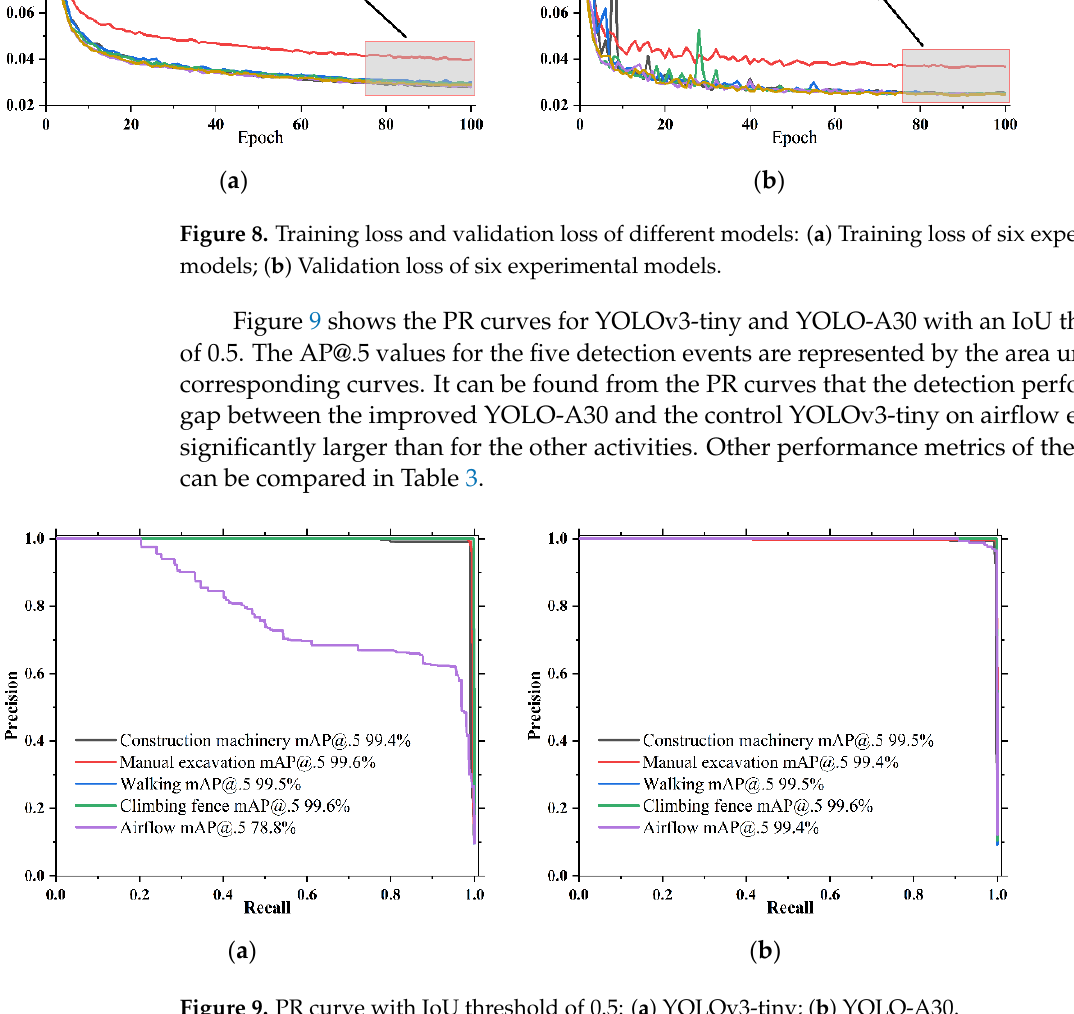
Figure 9. PR curve with IoU threshold of 0.5: ( a ) YOLOv3-tiny; ( b ) YOLO-A30. Table 3. Models performance metrics statistics.